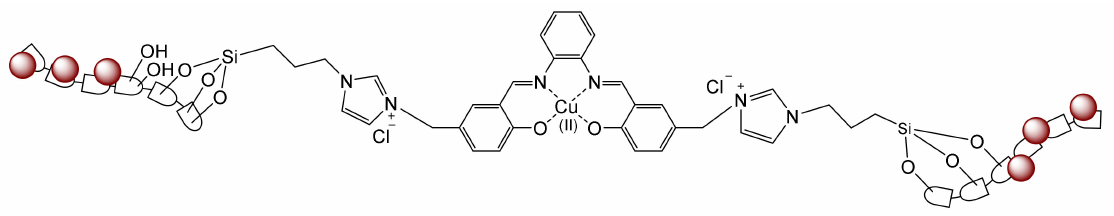
Figure 8. Fe 3 O 4 @CNF-ImSalophCu